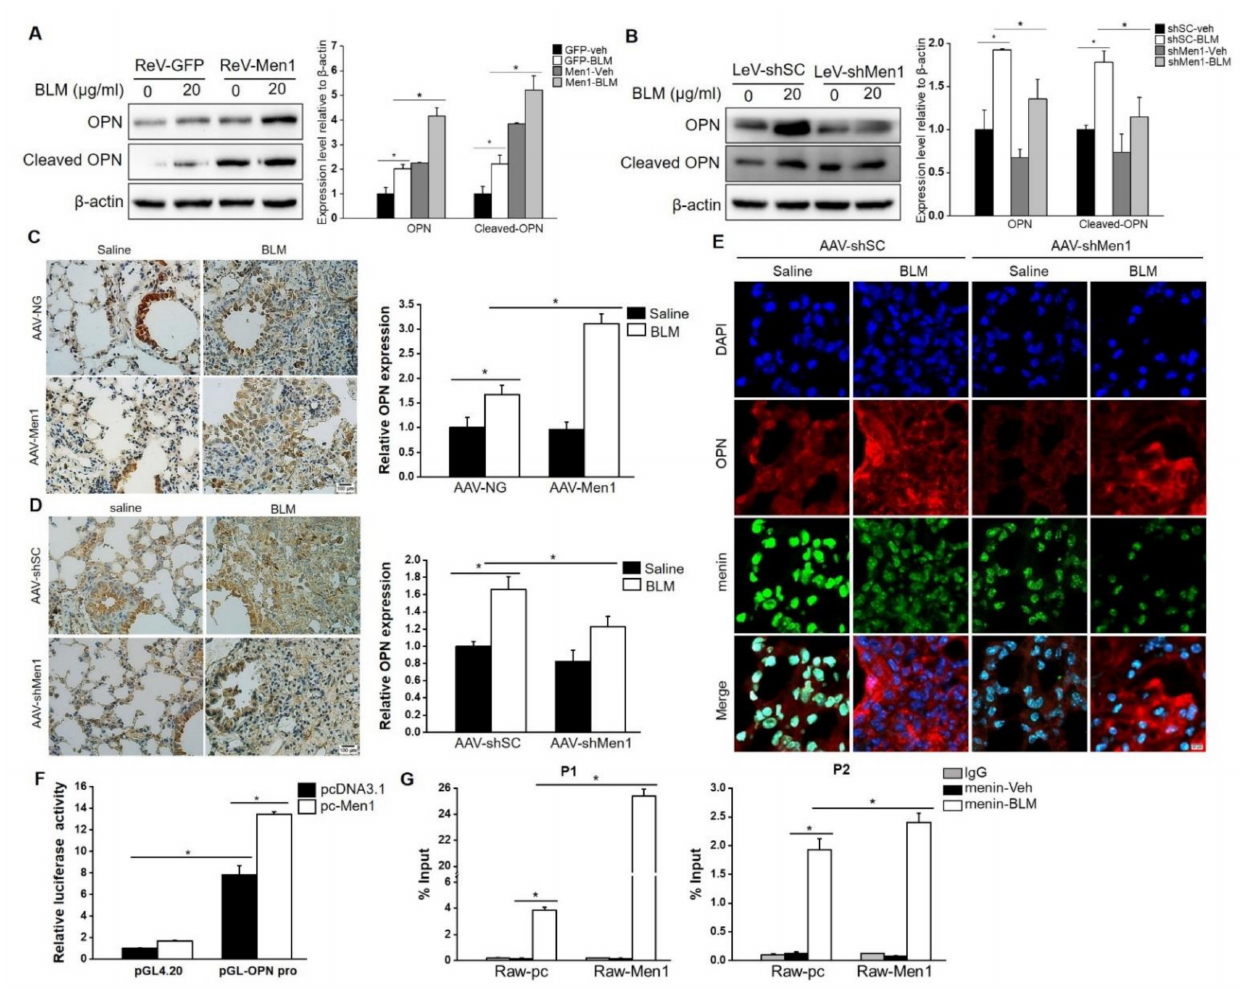
Figure 8. Menin positively regulates OPN expression at the transcription level. ( A , B ) Raw264.7 cells overexpressing Men1 or having Men1 knockdown were exposed to BLM, and the protein level of OPN was determined by Western blotting. Blots from two repeated experiments were quantified by Image J software. ( C , D ) IHC staining was performed to detect the expression and distribution of OPN in lung tissue of Men1 overexpressing or Men1 knockdown mice. Quantification of OPN expression was analyzed by Image J software ( n = 6 for ( C ) and n = 5 for ( D )). Scale bar: 100 µ m. ( E ) The expressions and distributions of OPN and menin in lung tissues were determined by IF staining. Scale bar: 20 µ m. ( F ) Dual − luciferase assay was performed in Men1 overexpressing 293T cells which were transfected with pGL4.20 or pGL-OPN pro plasmids. The Firefly luciferase activity or Ranilla luciferase activity were determined by a luminescent microplate reader. Firefly luciferase activity was normalized to Ranilla luciferase activity. Data are from three repeated experiments ( G